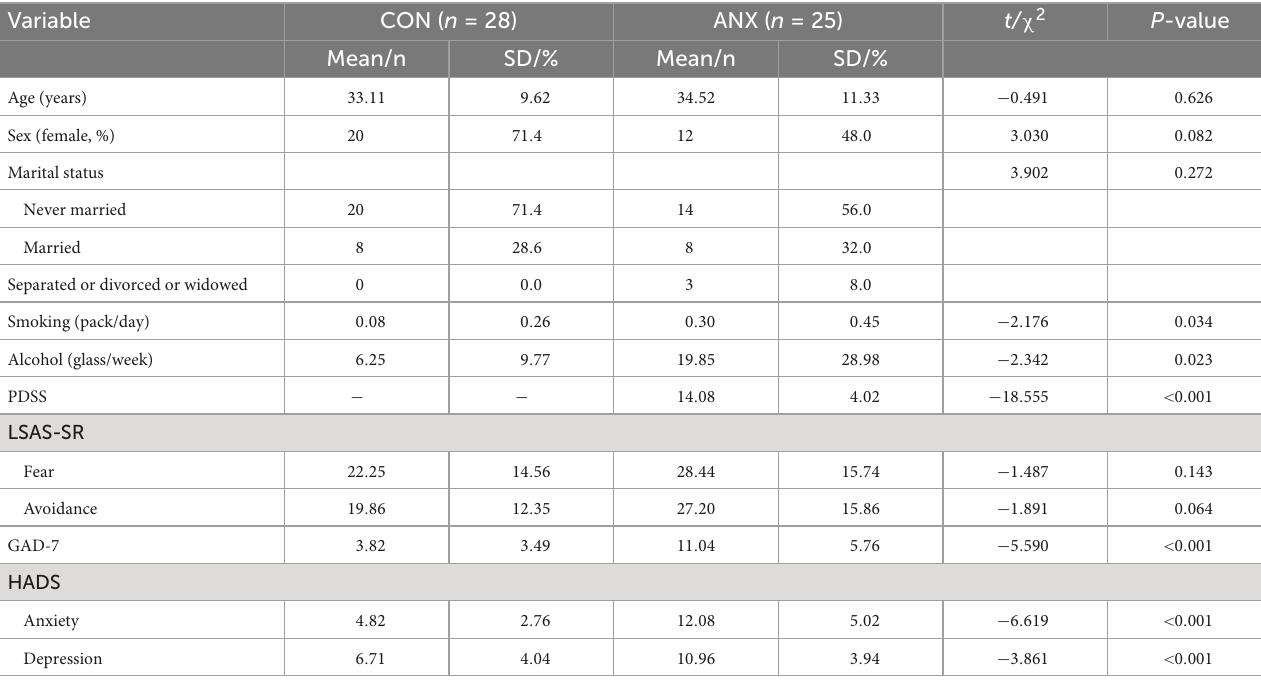
TABLE 1 Demographic and psychological characteristics of each